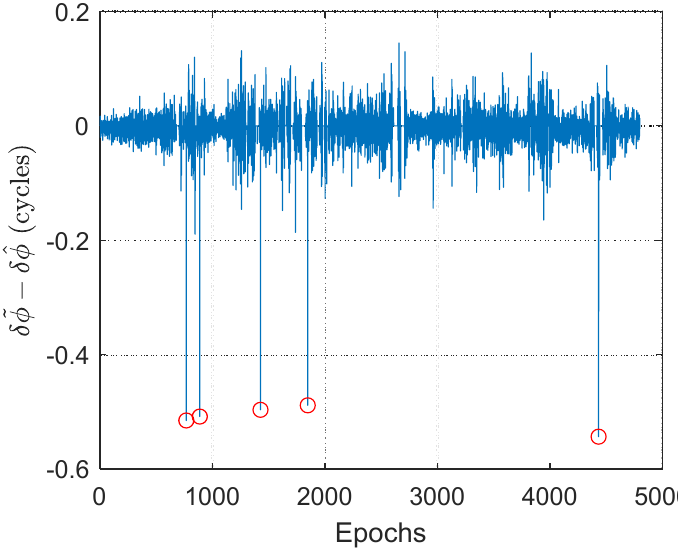
Figure 5. Doppler-aided cycle slip detection of the global positioning system (GPS) satellite with pseudorandom number (PRN) G01. Detected cycle slips are marked with red circles.